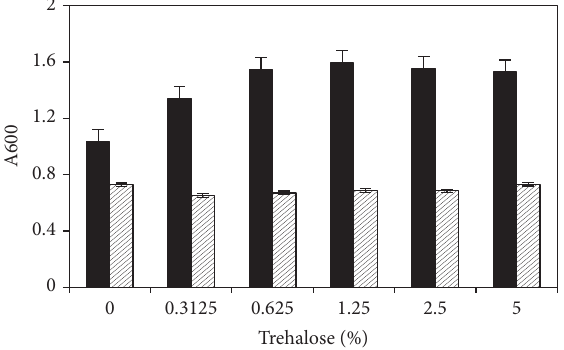
Figure 2: Effect of different concentrations of trehalose on the growth of wild type C. perfringens ATCC 13124 (black bars) and mutant 13124 GR (cross-hatched bars) in brain heart infusion